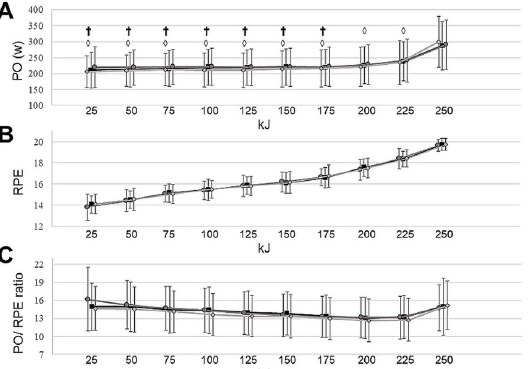
Fig 5. A: Average power output (PO) for each 25 kJ interval of the 250-kJ time trial (TT). B: Average rate of perceived exertion (RPE) for each 25 kJ interval of the 250-kJ TT. C: PO/RPE-ratio for each 25 kJ interval of the 250-kJ TT. The black squares represent the a-tDCS condition, the dark grey circles represents the sham condition, and the light grey diamonds represents the control condition. The error bars represent the standard deviation. † denotes a significant difference from the interval between 200–225 kJ. ^ denotes a significant difference from the interval between 225- 250kJ. N = 20.